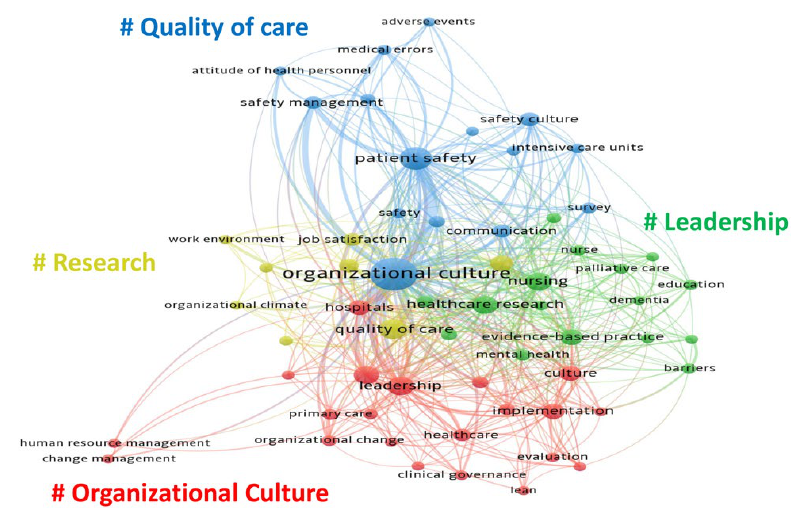
Figure 5. Co-occurrence analysis of organisational culture research in healthcare.